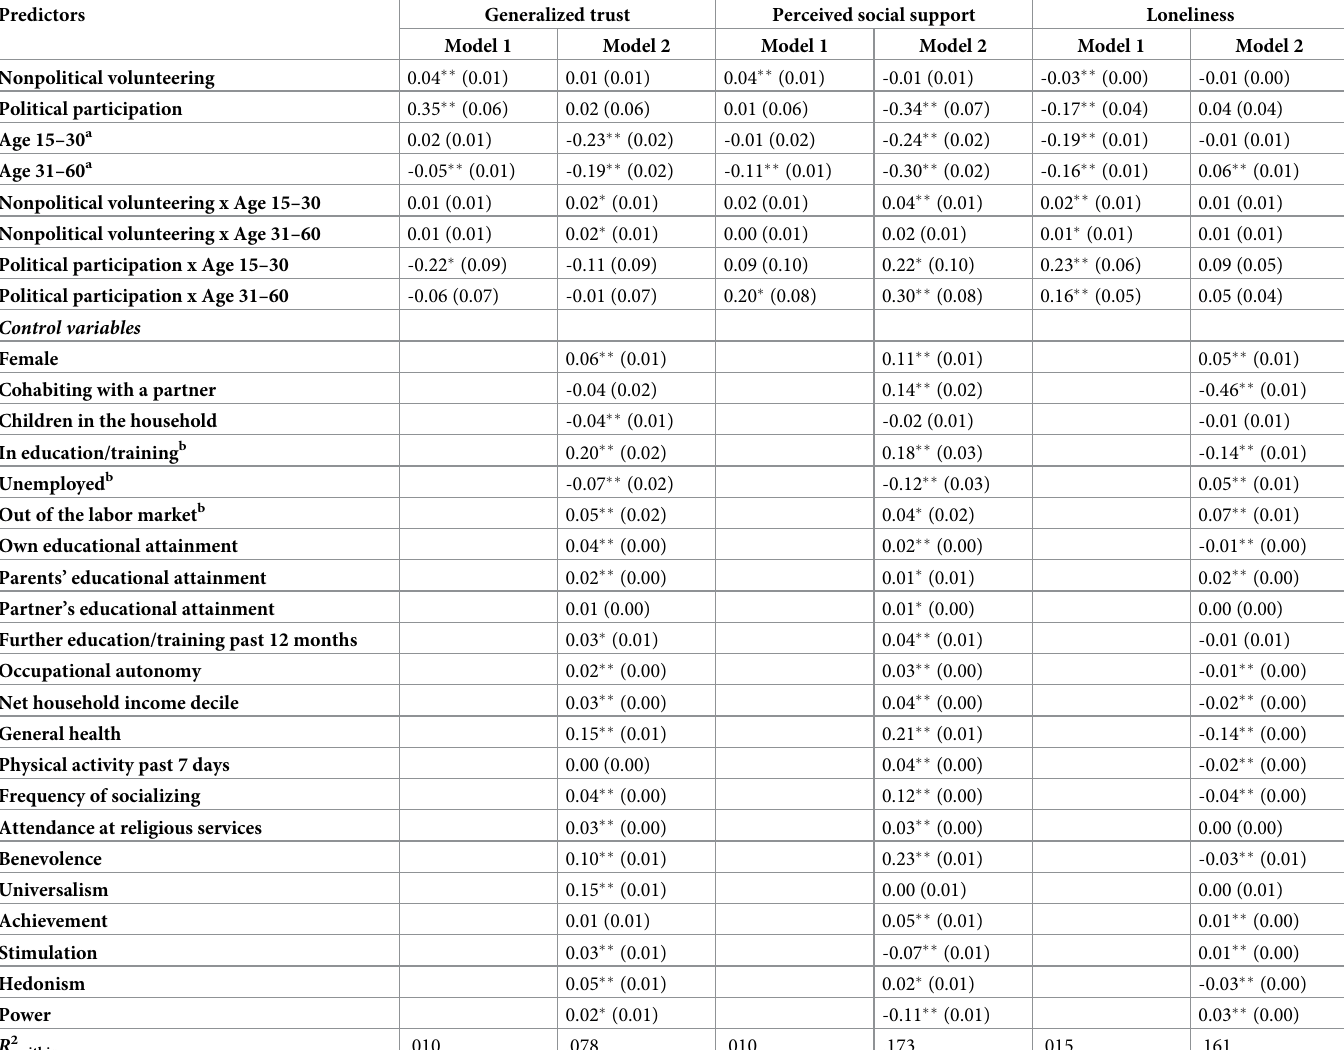
Table 5. Individual-level effects of nonpolitical volunteering and political participation on social well-being.